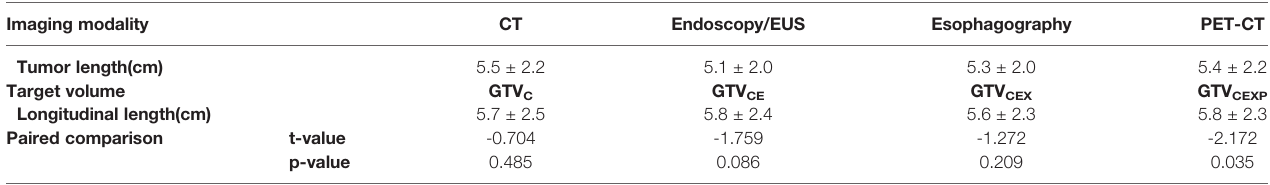
TABLE 3 | Comparison the tumor length measured by CT, endoscopy/EUS, esophagography, and FDG-PET/CT with the mean longitudinal length measured by fi ve observers for GTV C , GTV CE, GTV CEX, and GTV CEXP . Imaging modality